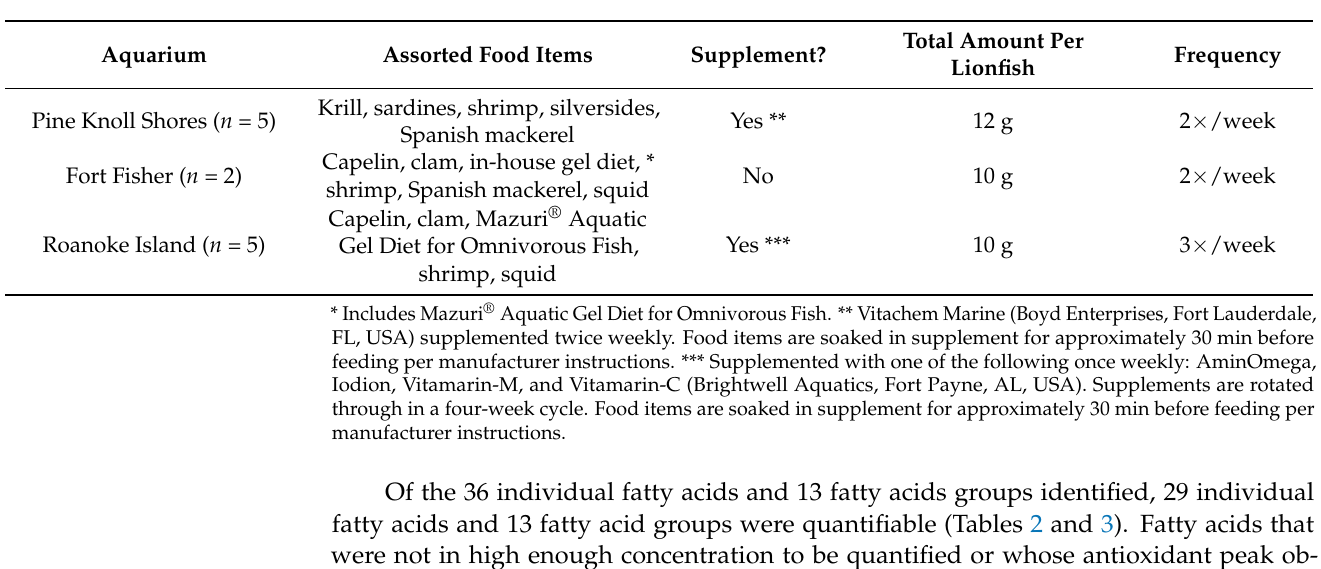
Table 1. Diets of lionfish at the North Carolina Aquariums. While diets varied among the three aquariums, lionfish were fed primarily pelagic fish, crustaceans, mollusks, commercial gel diets and nutrient